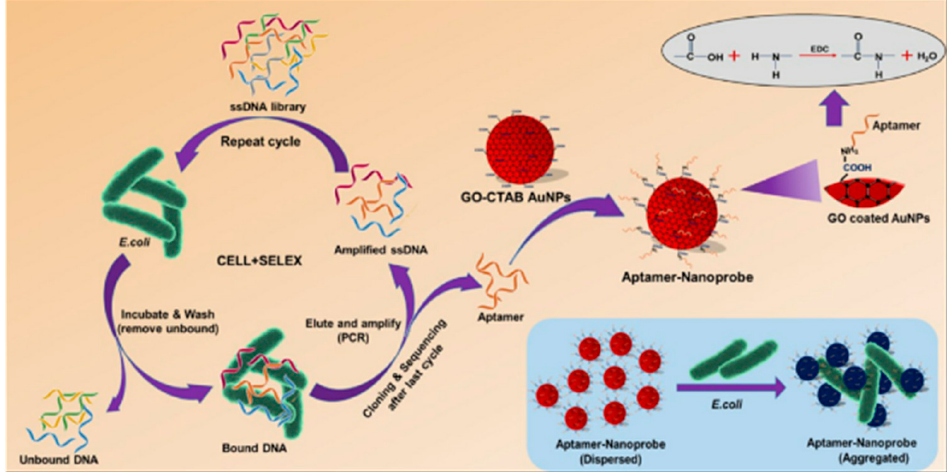
Figure 5. Colorimetric detection of Escherichia coli with GO-coated AuNPs and binding of aptamer. Reprinted with permission from Ref. [18], Copyright 2021, Elsevier.